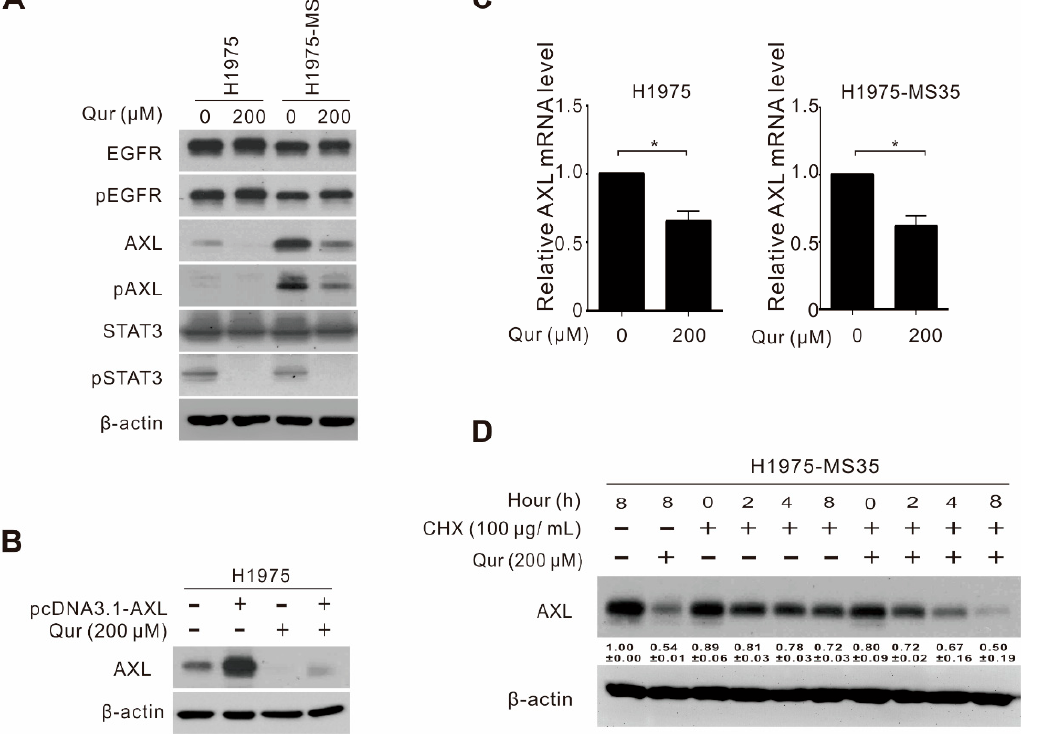
Figure 3. Inhibition of AXL by quercetin in NSCLC cells. ( A ) H1975 and H1975-MS35 cells were treated with quercetin for 24 h, and the cell lysates were assayed for AXL, EGFR, STAT3, phospho (p)-AXL, (p)-EGFR, and (p)-STAT3 expression by Western blotting. β -Actin served as the loading control. ( B ) H1975 cells were transfected with pcDNA3.1-AXL or with pcDNA3.1. After 48 h, the transfected cells were treated with 200 μ M quercetin for 24 h, and the levels of AXL were assessed by Western blotting. β -Actin served as the internal control. ( C ) H1975 and H1975-MS35 cells were treated with quercetin for 24 h, and the levels of AXL mRNA were determined by real-time RT-PCR. The expression of AXL mRNA was normalized to that of the untreated cells and is presented as relative expression levels. The data shown are presented as the mean ± SD values. Symbols: * p < 0.05 as analyzed by unpaired t -tests. ( D ) H1975-MS35 cells were incubated with cycloheximide (CHX) for the indicated times in the absence or presence of quercetin. The relative expression levels of AXL were quantified and are shown at the bottom. β -Actin served as the internal control. The data are expressed as the mean ± SD of three independent experiments.